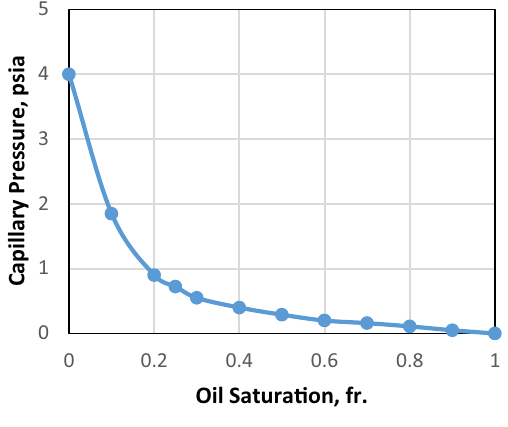
Fig. 3 Reservoir capillary pressure